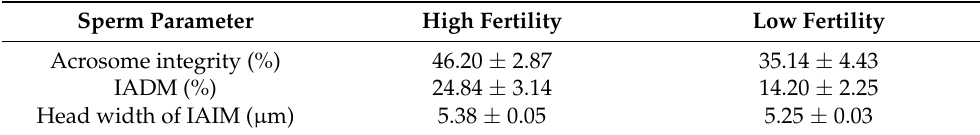
Table 1. Differences in sperm quality parameters between high- and low-fertility bulls. Data are represented as mean ± S.E.M.